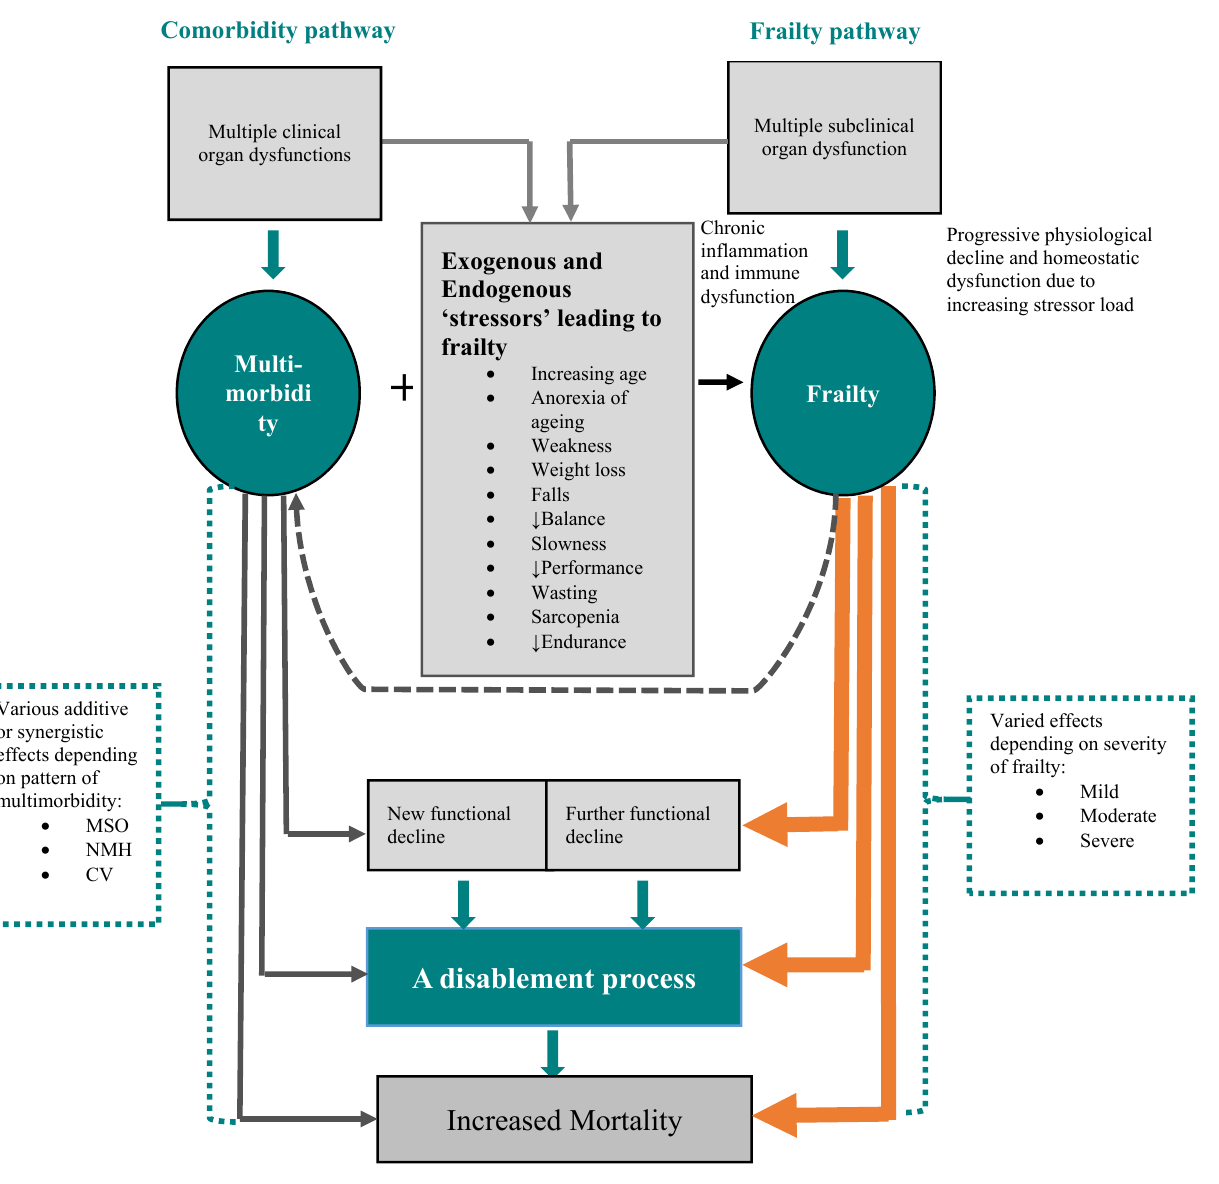
Figure 2. Multimorbidity-frailty interaction. Multiple subclinical organ dysfunction lead to frailty, multimorbidity associated with other factors such as weakness lead to frailty, both multimorbidity and frailty lead to disability, which in turn worsens multimorbidity and frailty and eventually increases mortality. MSO=Musculoskeletal/somatic, NMH=Neurological/mental health, CV=cardiovascular.